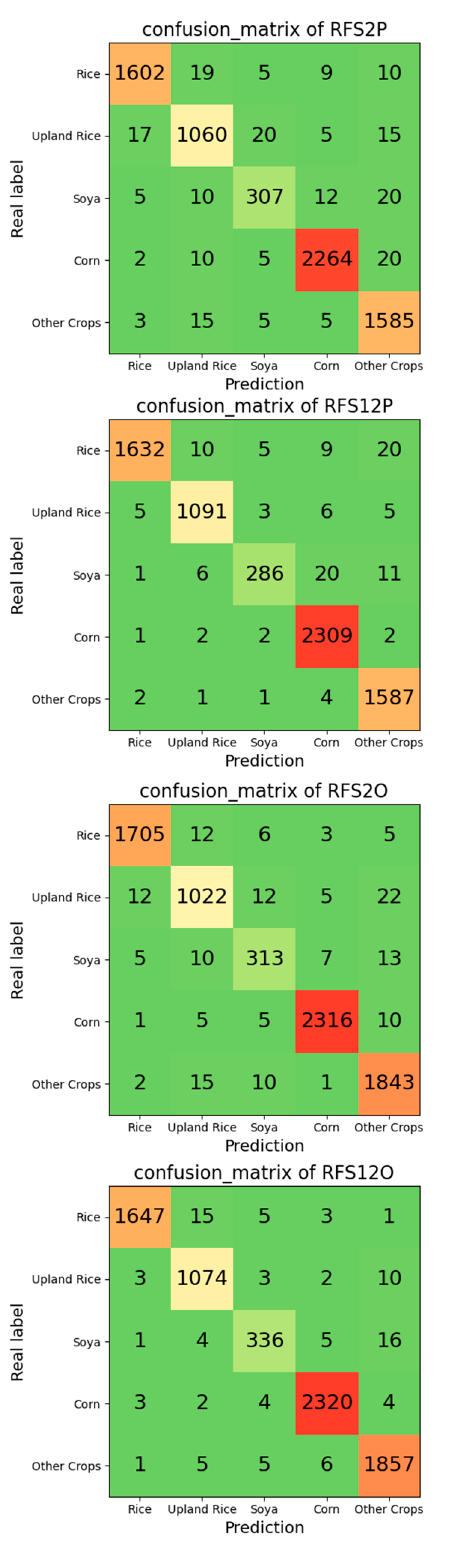
Figure 8. Confusion matrix of the classification results. “RF” means random forest, “SVM” means support vector machine, “S2” means only Sentinel-2 images were used, “S12” means Sentinel-1 SAR and Sentinel-2 images were used, “P” means the pixel-based method, and “O” means the object-oriented method.